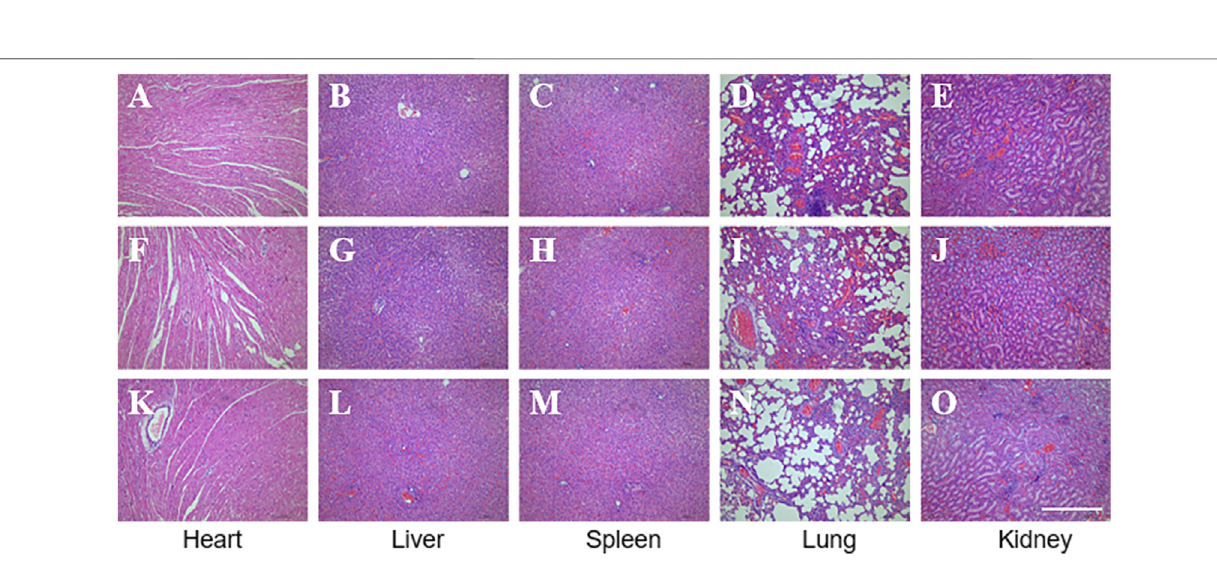
Frontiers in Bioengineering and Biotechnology |